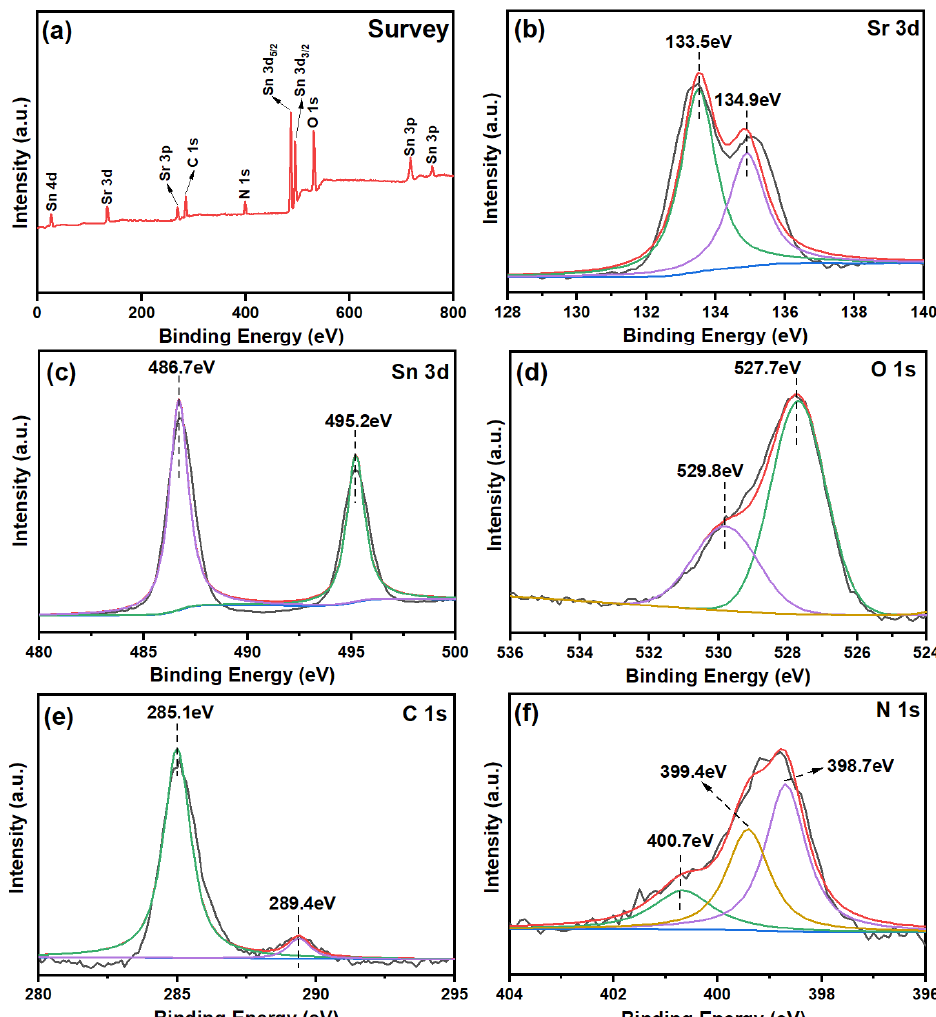
Figure 3. XPS survey pattern of 40SSO/CN ( a ); the high-resolution XPS spectra of Sr 3d ( b ), Sn 3d ( c ), O 1s ( d ), C 1s ( e ), and N 1s ( f ).